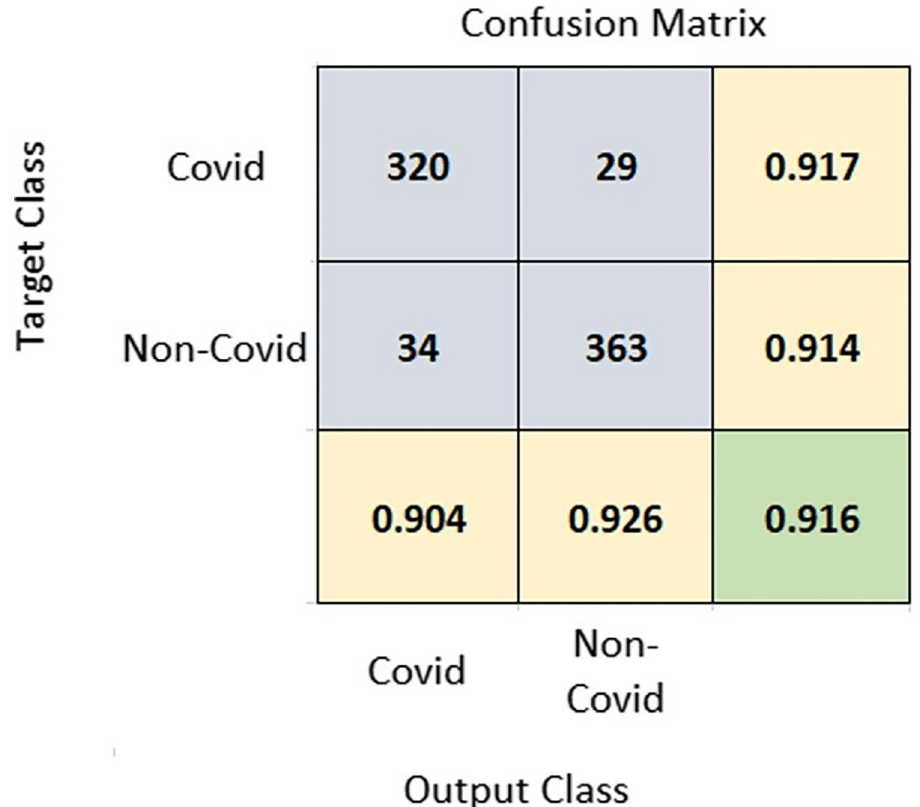
Fig 8. Confusion matrix for result analysis of RNNCON-Res.